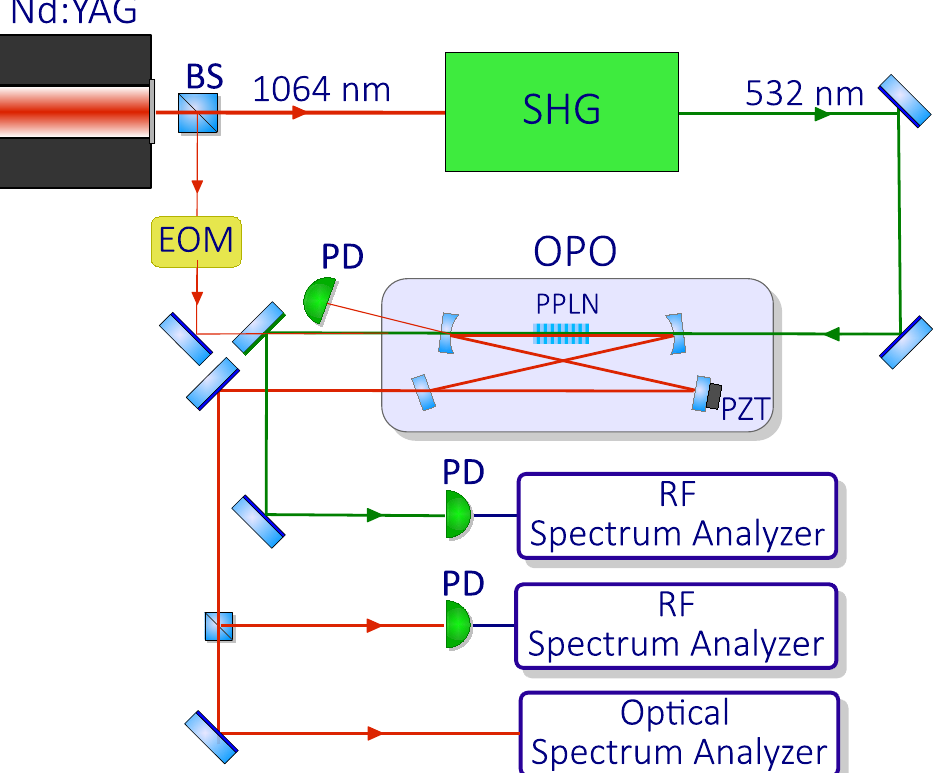
Figure 7. OFC in a degenerate OPO. Scheme of the experimental setup: beam splitter (BS), electro-optic phase modulator (EOM), periodically poled lithium niobate crystal (PPLN), piezoelectric actuator (PZT), photodiode (PD). Adapted with permission from [54]. Copyrighted by the American Physical